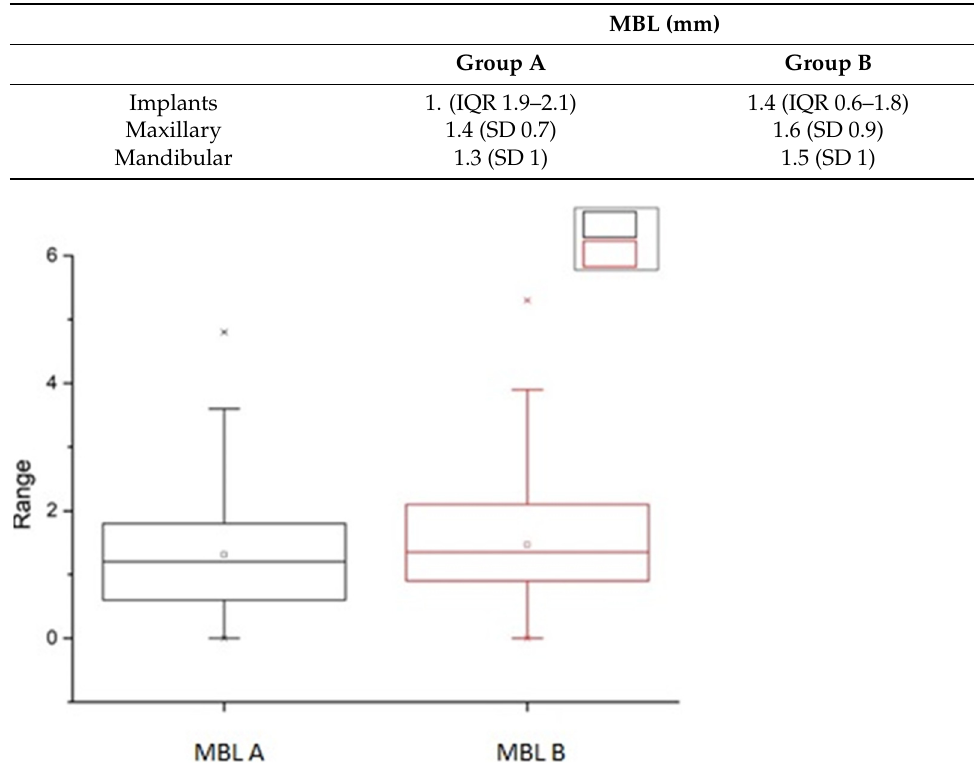
Figure 5. Mean MBL with IQR.